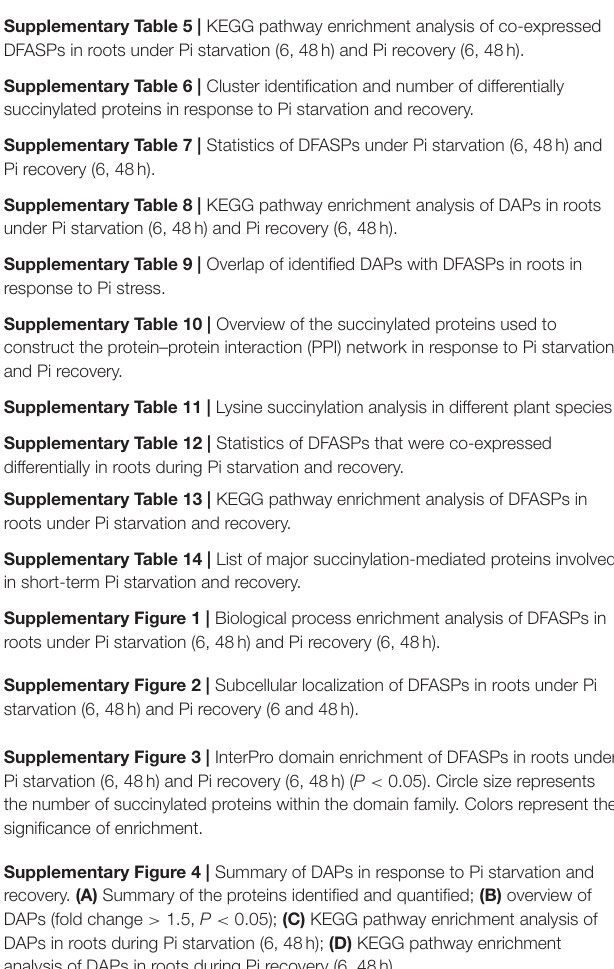
Supplementary Table 3 | GO enrichment analysis of DFASPs in roots under Pi starvation (6, 48h) and Pi recovery (6, 48h).